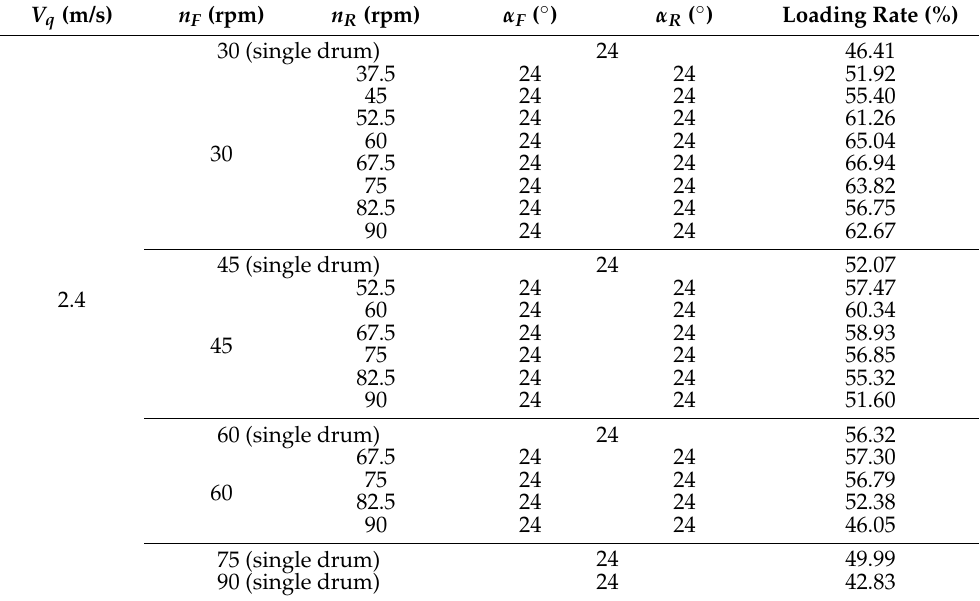
Table 5. The statistical results of loading rate under different rotational speed matching.